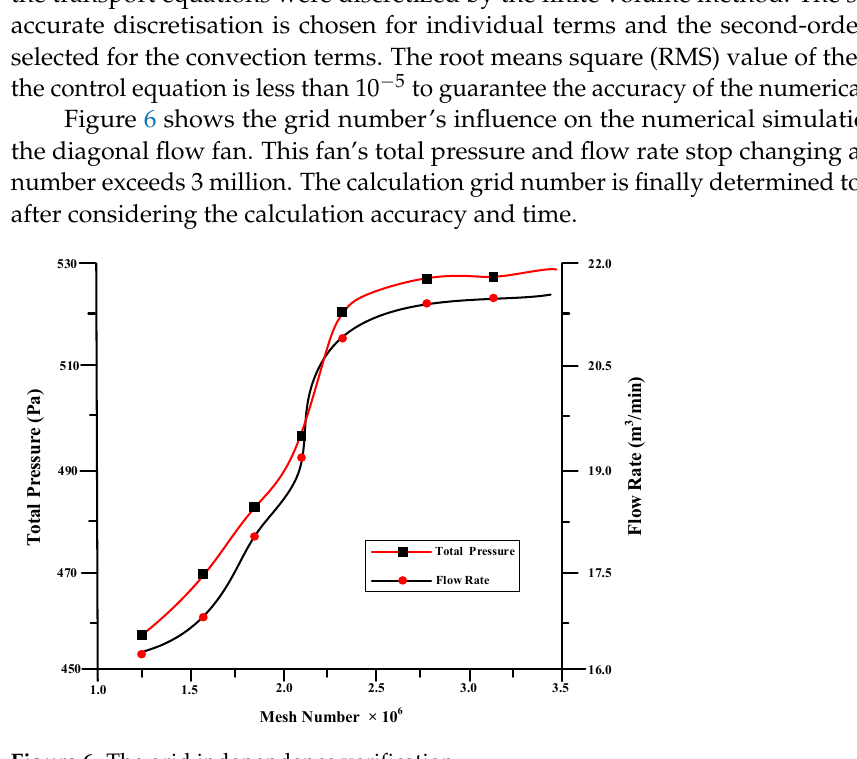
Figure 6. The grid independence verification.